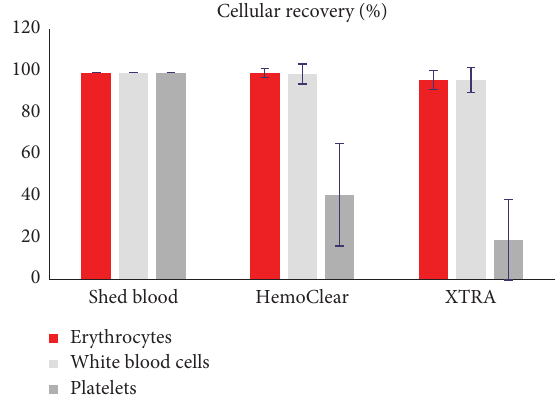
Figure 6: Cellular recovery in concentrated